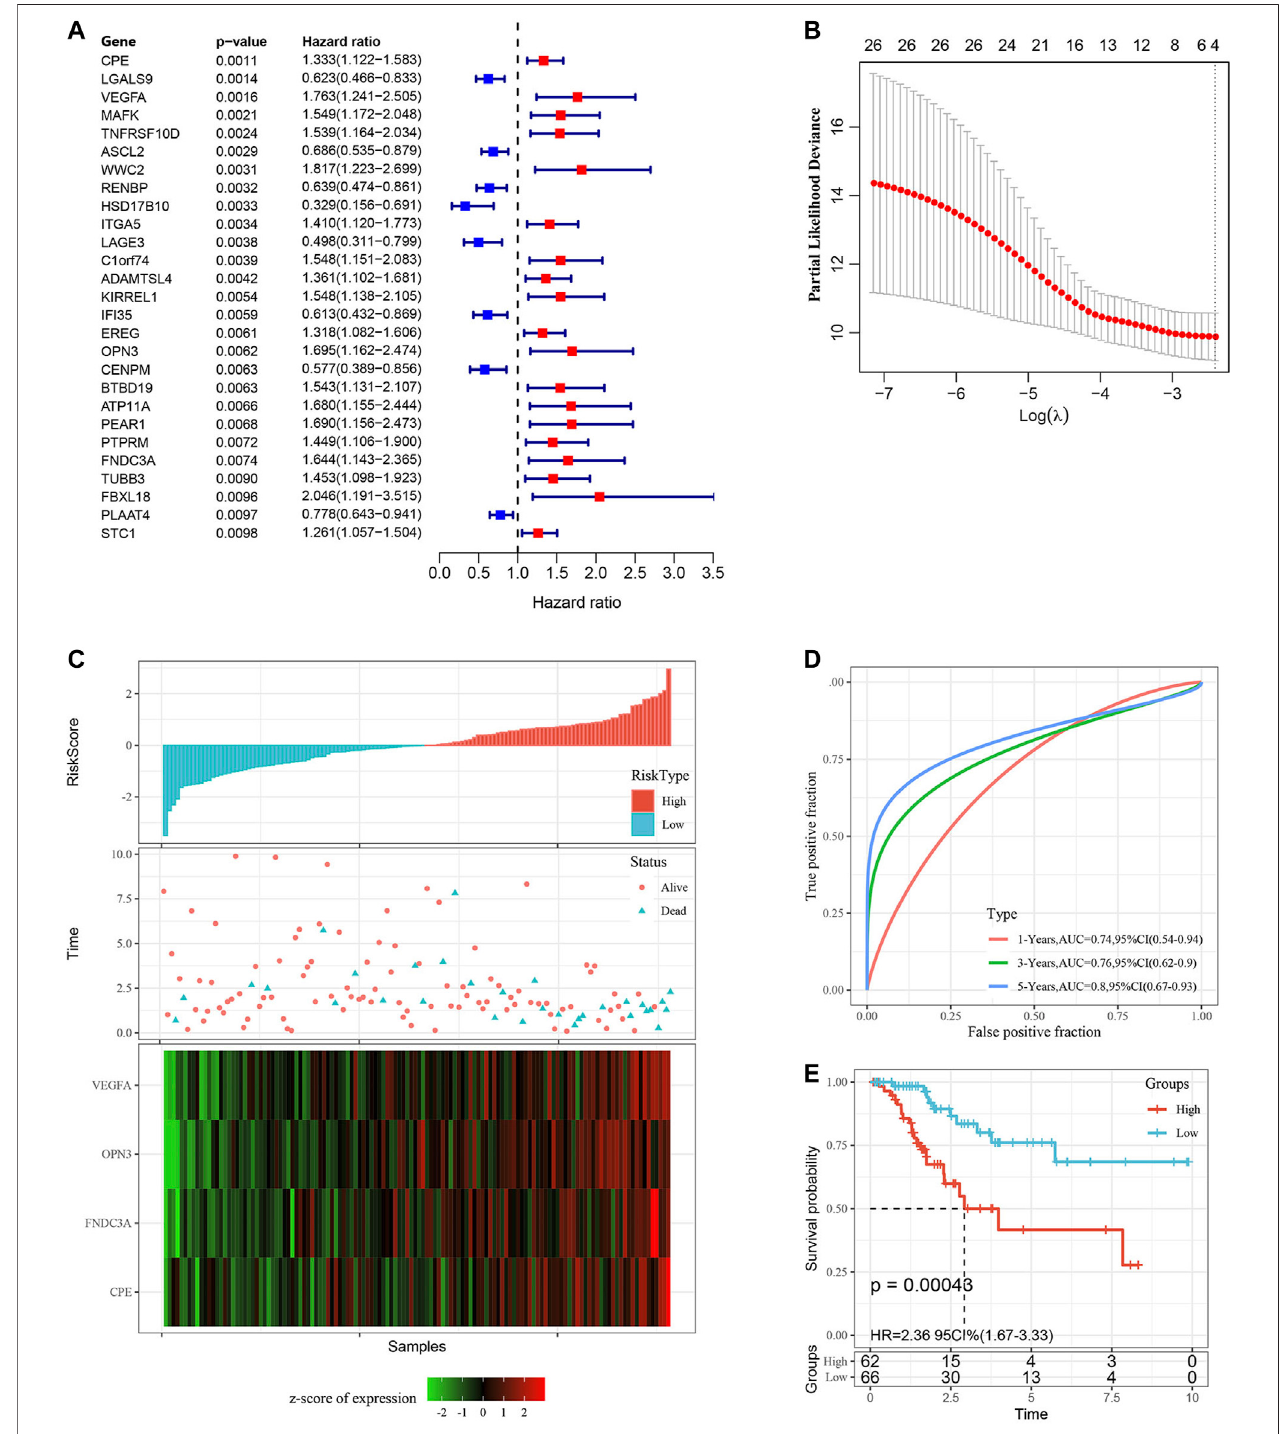
FIGURE 5 | Construction and evaluation of the gene signature in the TCGA training set. (A) 27 DEGs were identi fi ed by univariate Cox analysis. (B) LASSO Cox regression. (C) Risk score distribution in the TCGA training set. (D) ROC curves were used toassess the ef fi ciency ofthe risksignature forpredicting 1 year, 3years and 5 years survival rates in the TCGA training set. (E) The KM survival curves of the low-risk group and the high-risk group in the TCGA training set. Time: years.